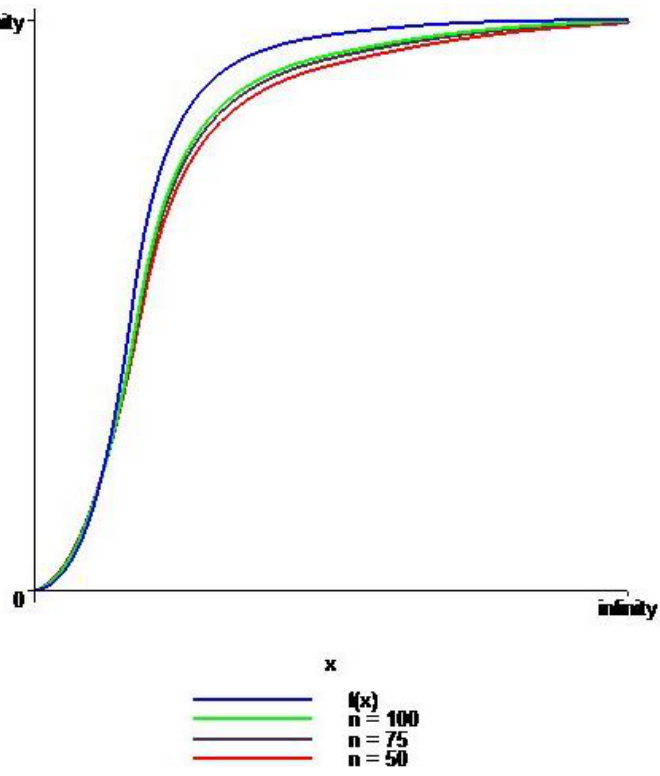
Figure 1. Approximation by R G n on [ 0, ∞ ) , for β n = 1 − 1